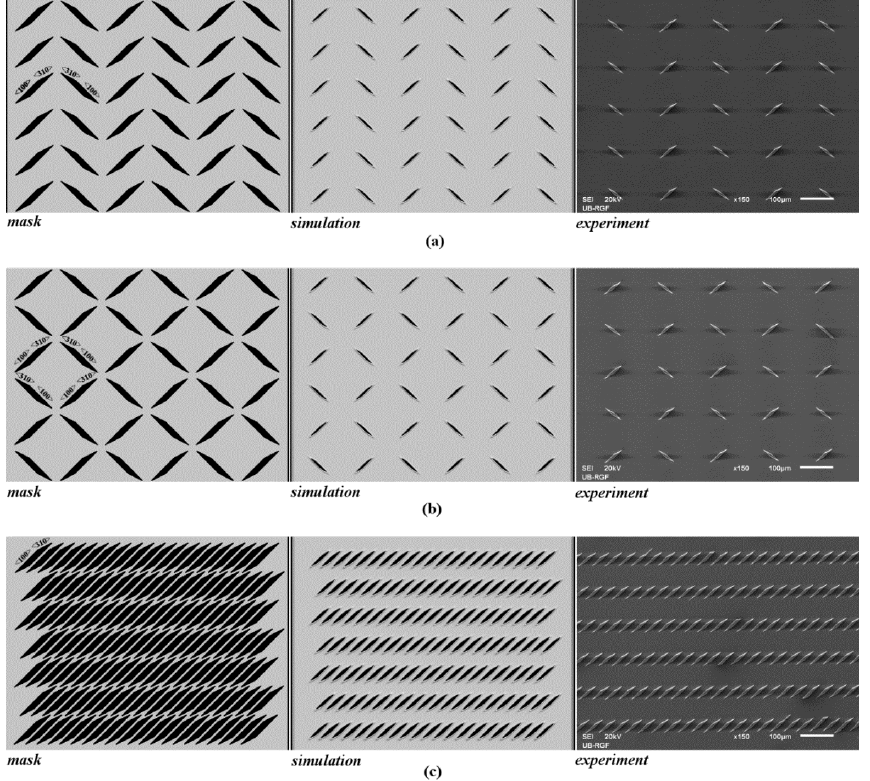
Figure 5. Mask patterns, simulated etching profiles and SEM micrographs (silicon-on-insulator (SOI) active layer) of three matrices of parallelograms with sides along crystallographic directions < 310 > and < 100 > : ( a ) fishbone patterns; ( b ) zigzag patterns; and ( c ) directed parallelograms. Etched depths in simulations and experiments are 6 µ m.